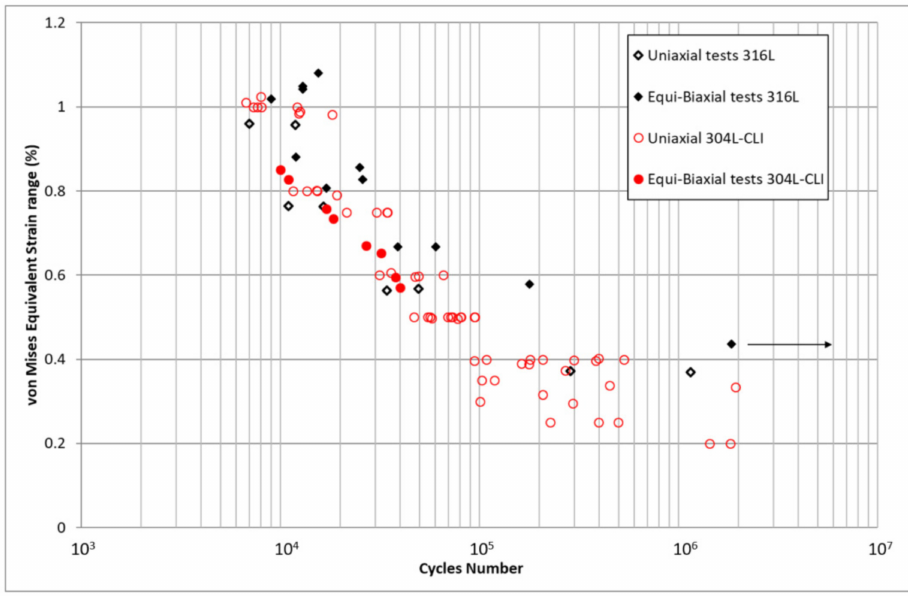
Figure 3. Fatigue data obtained on the two austenitic stainless steels (316L and